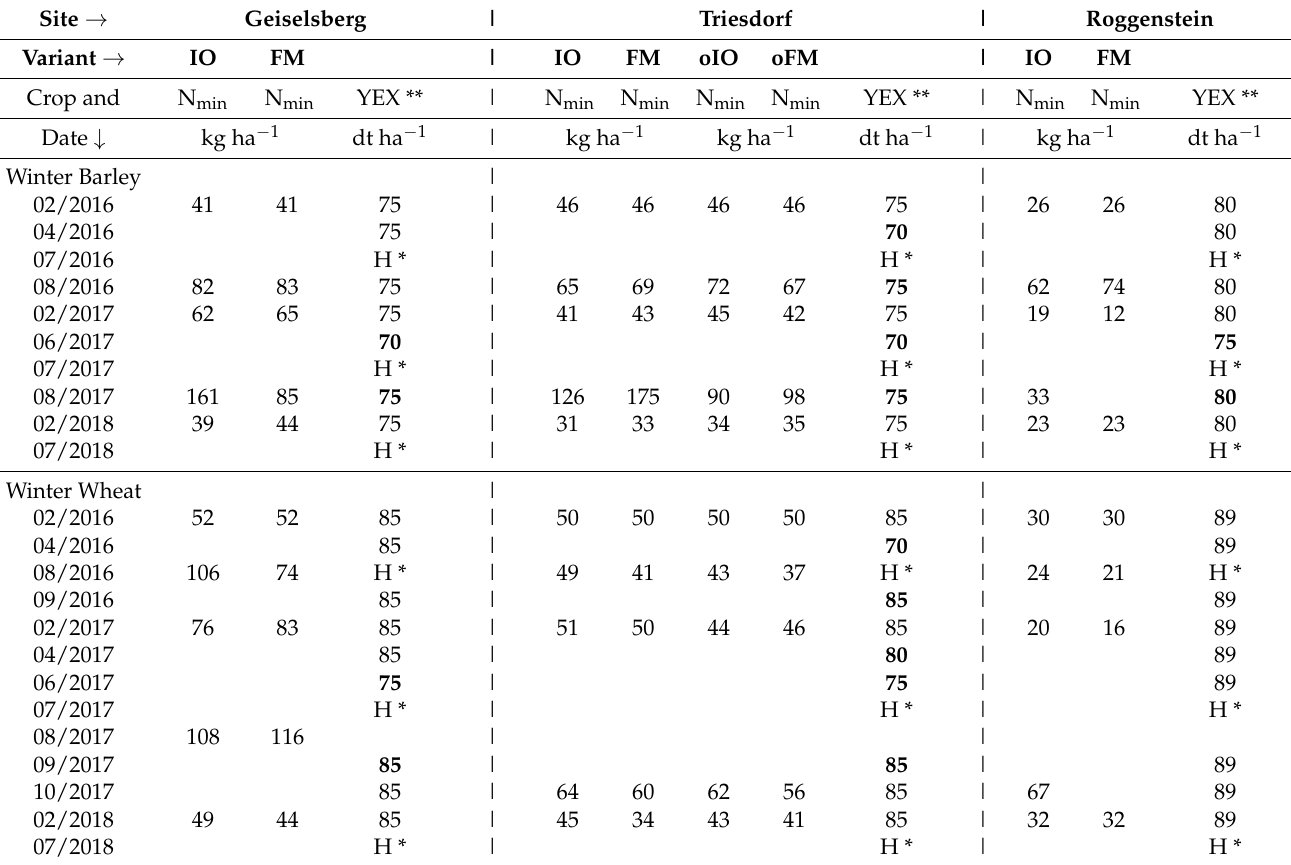
Table A2. Results from soil testing (N min ) and farmers’ yield expectation